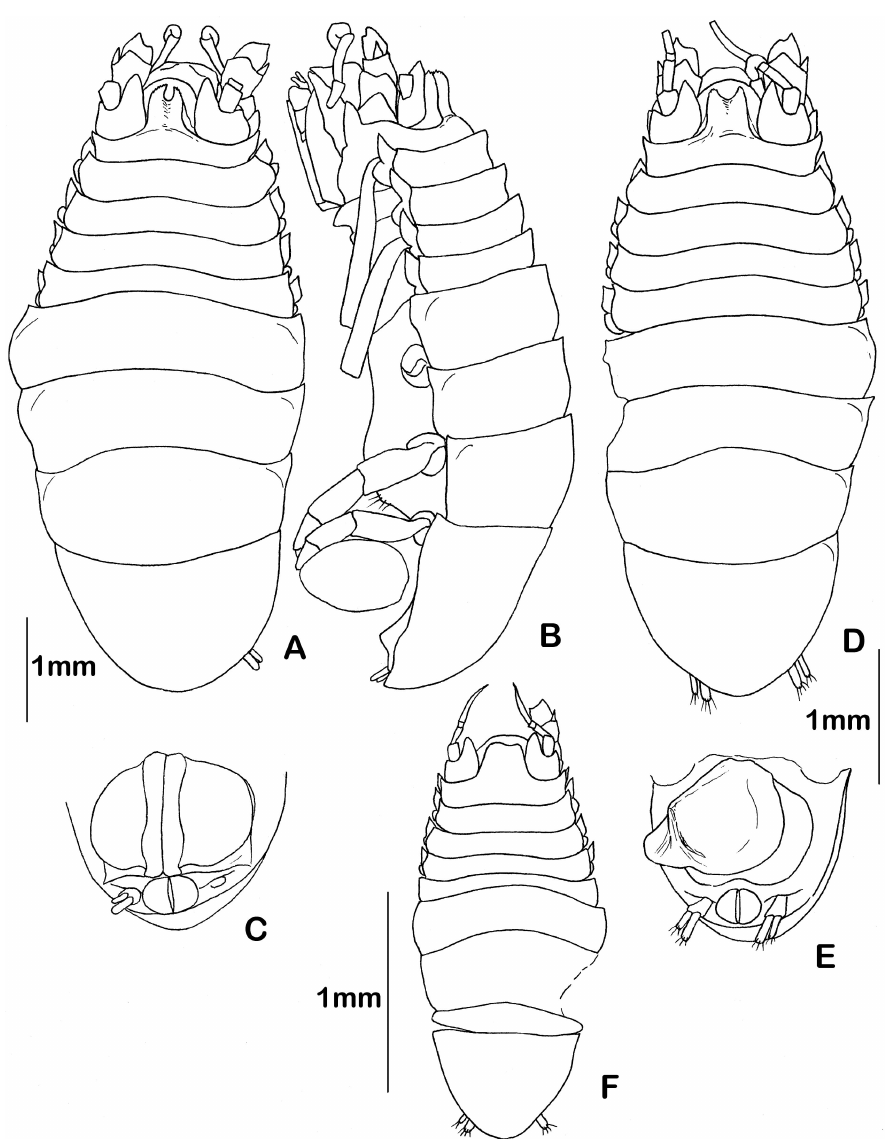
Figure 10. Eurycope dahli Svavarsson, 1987. Male (ZMH K-45598): ( A ) dorsal view; ( B ) lateral view; ( C ) pleotelson, ventral view. Female (ZMH K-45612): ( D ) dorsal view; ( E ) pleotelson, ventral view; juvenile (ZMH-K 45606): ( F ) dorsal